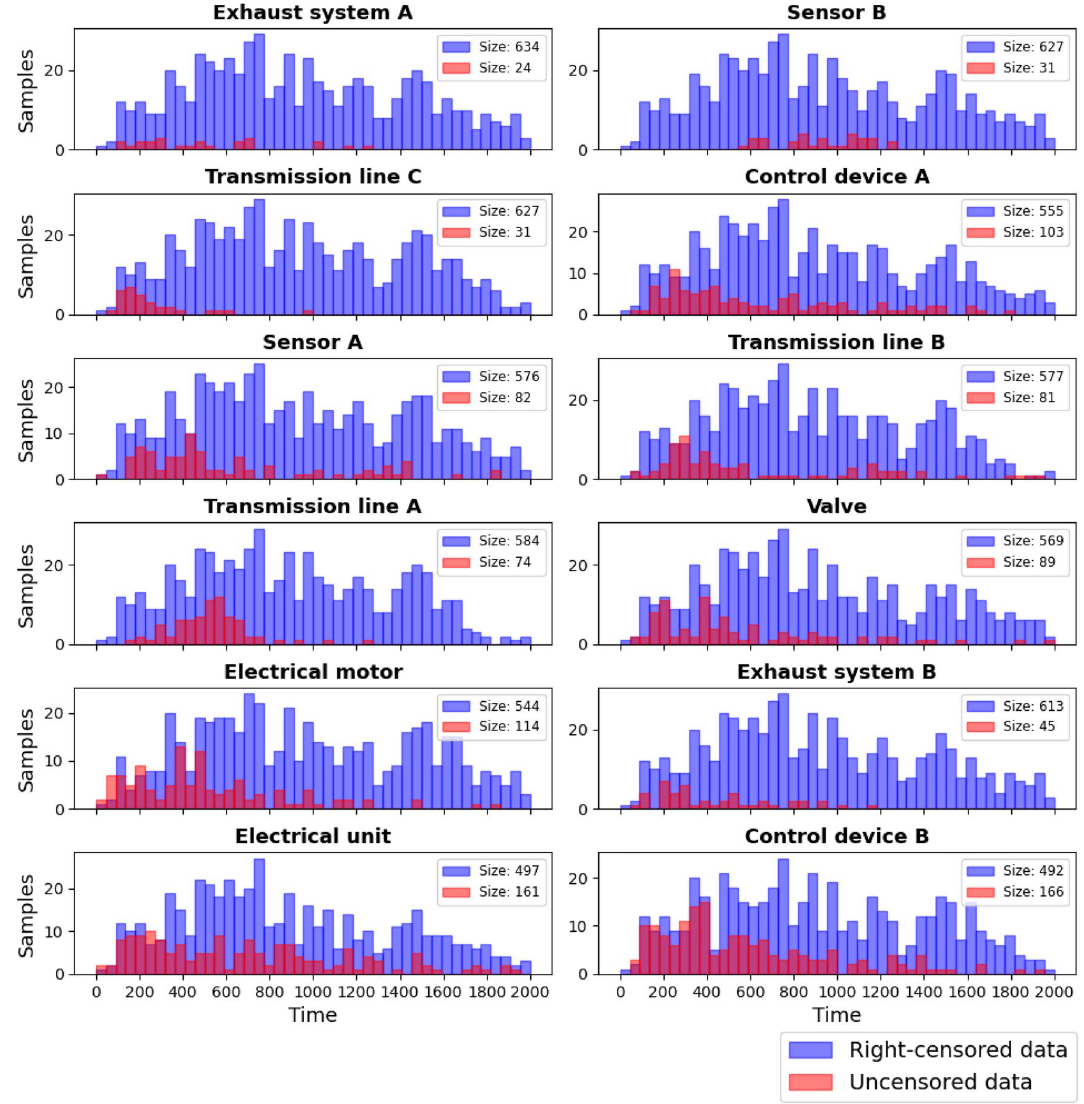
Figure 5. Histograms for replacement periods for all the events for 12 machine components. The right- censored events are highlighted in blue and the uncensored events are shown in